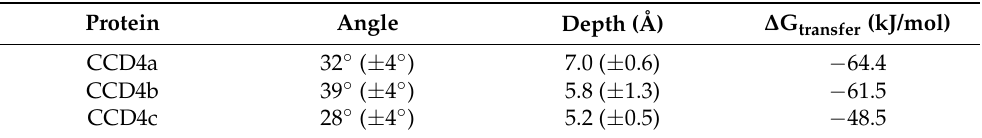
Table 2. Values of the angle of inclination of the proteins’ first principal axis of inertia with respect to the membrane plane, of the depth of penetration in the membrane, and of the free energy of transfer from the solvent to the membrane ( ∆ G transfer ).